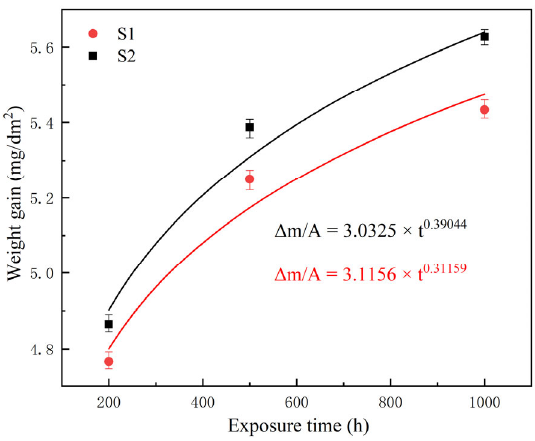
Figure 2. Oxidation kinetic curves of samples S1 and S2 in CO 2 at 650 ◦ C under 3.5 MPa for 1000